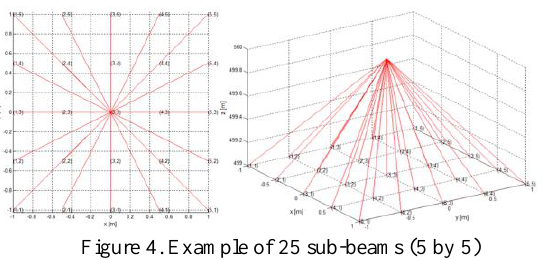
Figure 4. Example of 25 sub-beams (5 by 5) 2.2.2 Integration : The aim of integration is to transform the line-equation of sub-beam defined in the internal coordinate system to an absolute coordinate system (WGS84). And it can be performed by GPS and IMU sensor. Figure 5 shows each coordinate system of the sub-modules (GPS, IMU and laser scanner) and their geometric relationships. For the integration, the sensor equation, which is a mathematical representation of the position where the sub-beam is reflected, is necessary, derived as Eq. (1). Table 1 describes the variables of sensor equation. The detailed geometric modelling of lidar system including systematic errors is reported by Schenk (2001).